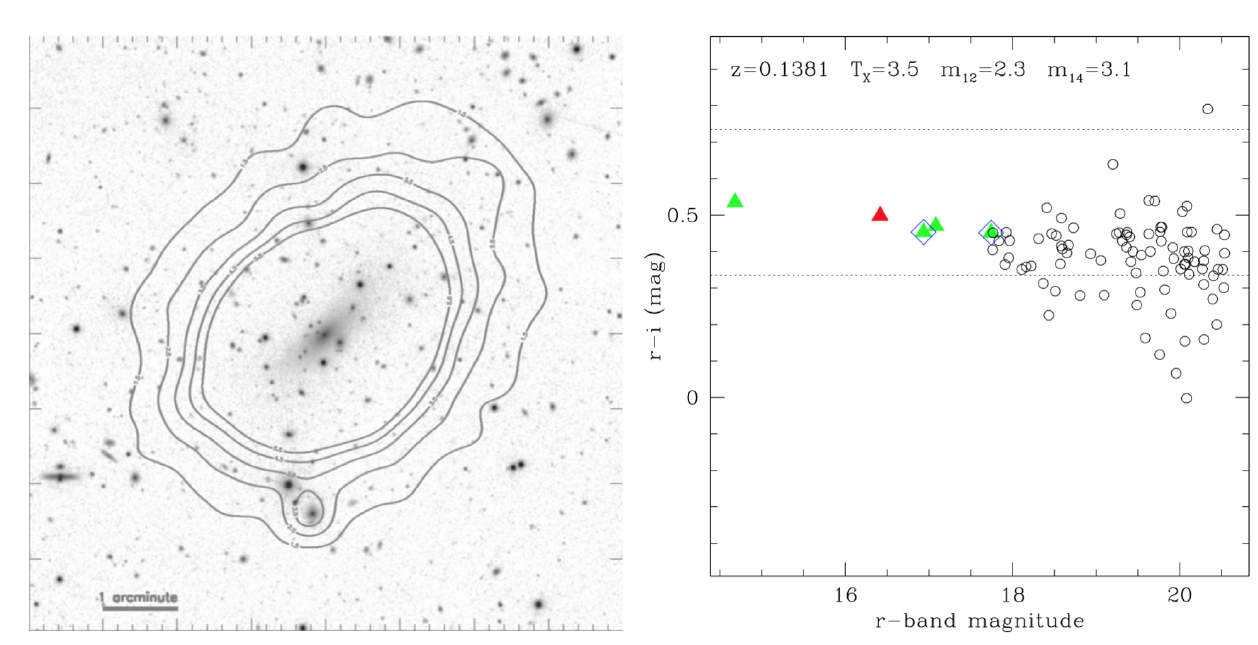
Figure 1. Left panel : SDSS image with X-ray contours of Abell 1068. Right panel : color-magnitude diagram of the same object. Green triangles are system members, whereas red triangles are those that are not. The redshift, ∆ m 12, and ∆ m 14 are reported in the right panel. The original image can be found in Harrison et al. [14]; in particular, it corresponds with their Figure